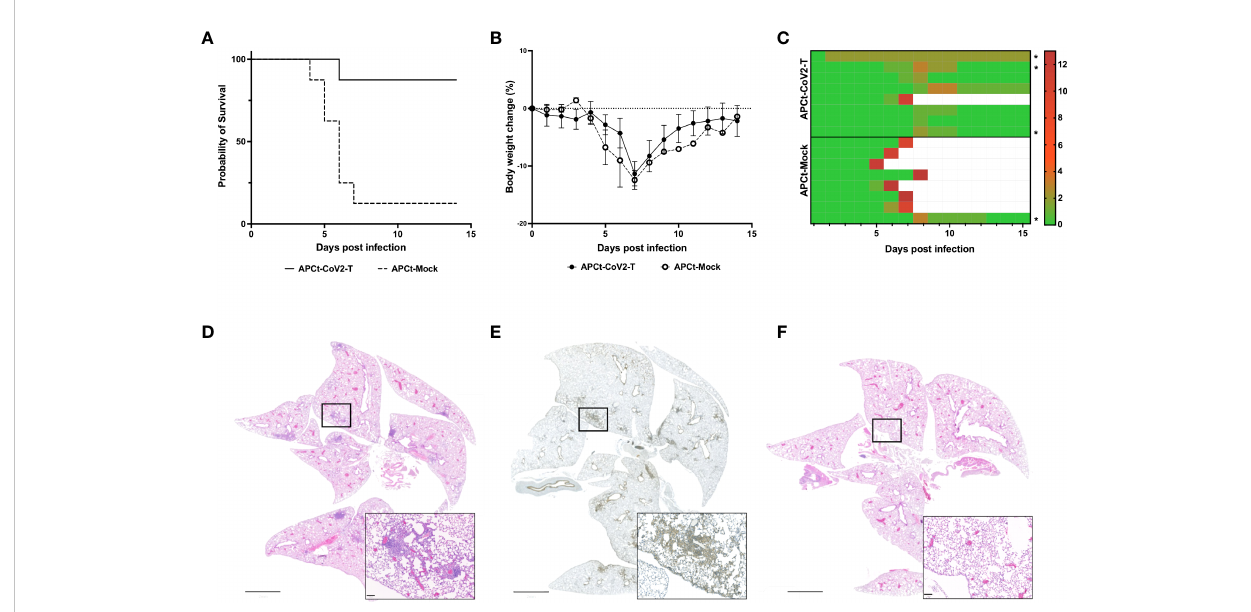
FIGURE 2 The RAVEN ™ (Rapidly Adaptive Viral predicted rEspoNse) antigen-presenting cell targeting (APCt)-CoV2-T vaccine increases survival in SARS-CoV- 2-infected K18-hACE2/BL6 mice. (A) Survival plot, (B) Body weight change, and (C) the total sum of clinical scores. The mice were monitored for 14 consecutive days post-infection. (D) Hematoxylin and eosin (H&E) staining and (E) CD45 immunohistochemistry (IHC) staining of the lungs of APCt- CoV2-T vaccinated mice. (F) H&E staining of the lungs from naïve mice at day 14 post-infection. The IHC images are representative of the three lungs evaluated (Figure S5). Scale bars are 2 mm and 100 m m. *Mice in which H&E and IHC staining of lung tissue was